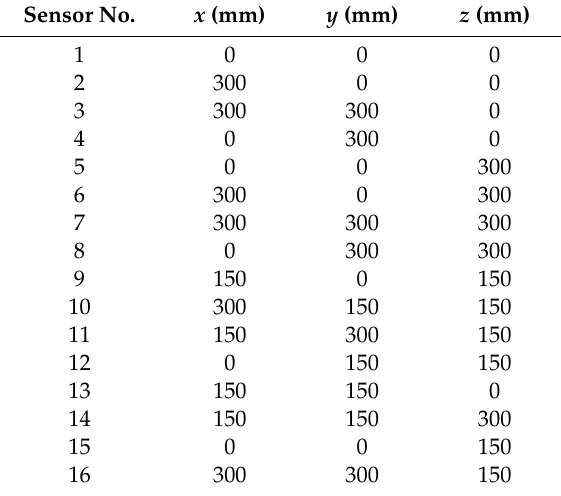
Figure 8. The sensor array and two AE sources inside and outside the array, respectively. Table 3. The coordinates of 16 AE sensors in the simulation test. Sensor